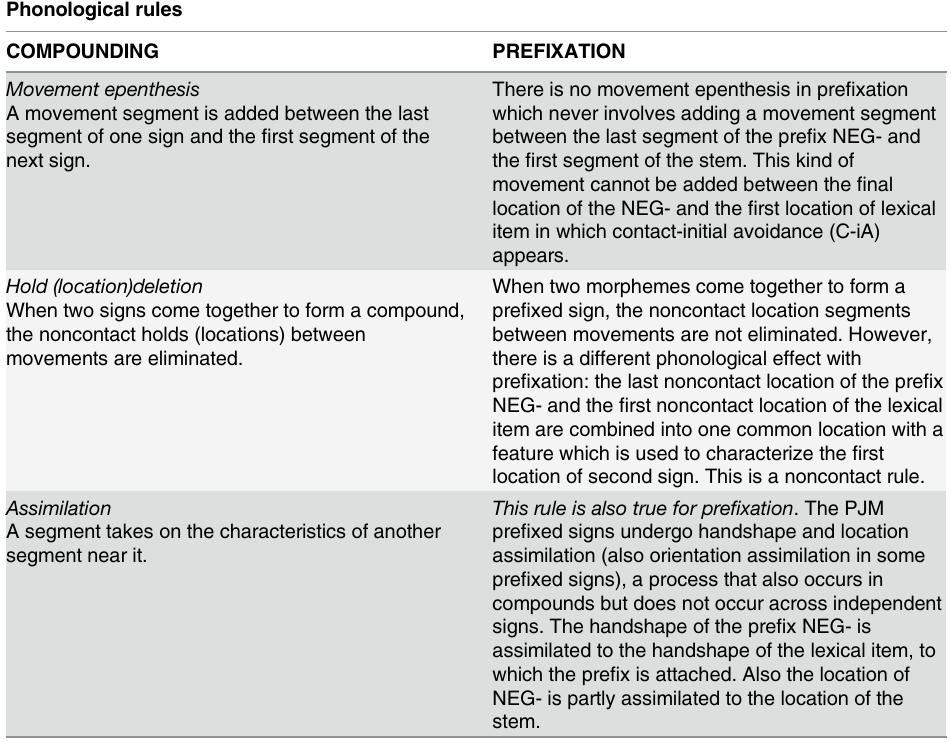
Table 5. Comparison of phonological constraints on sequential compounding and